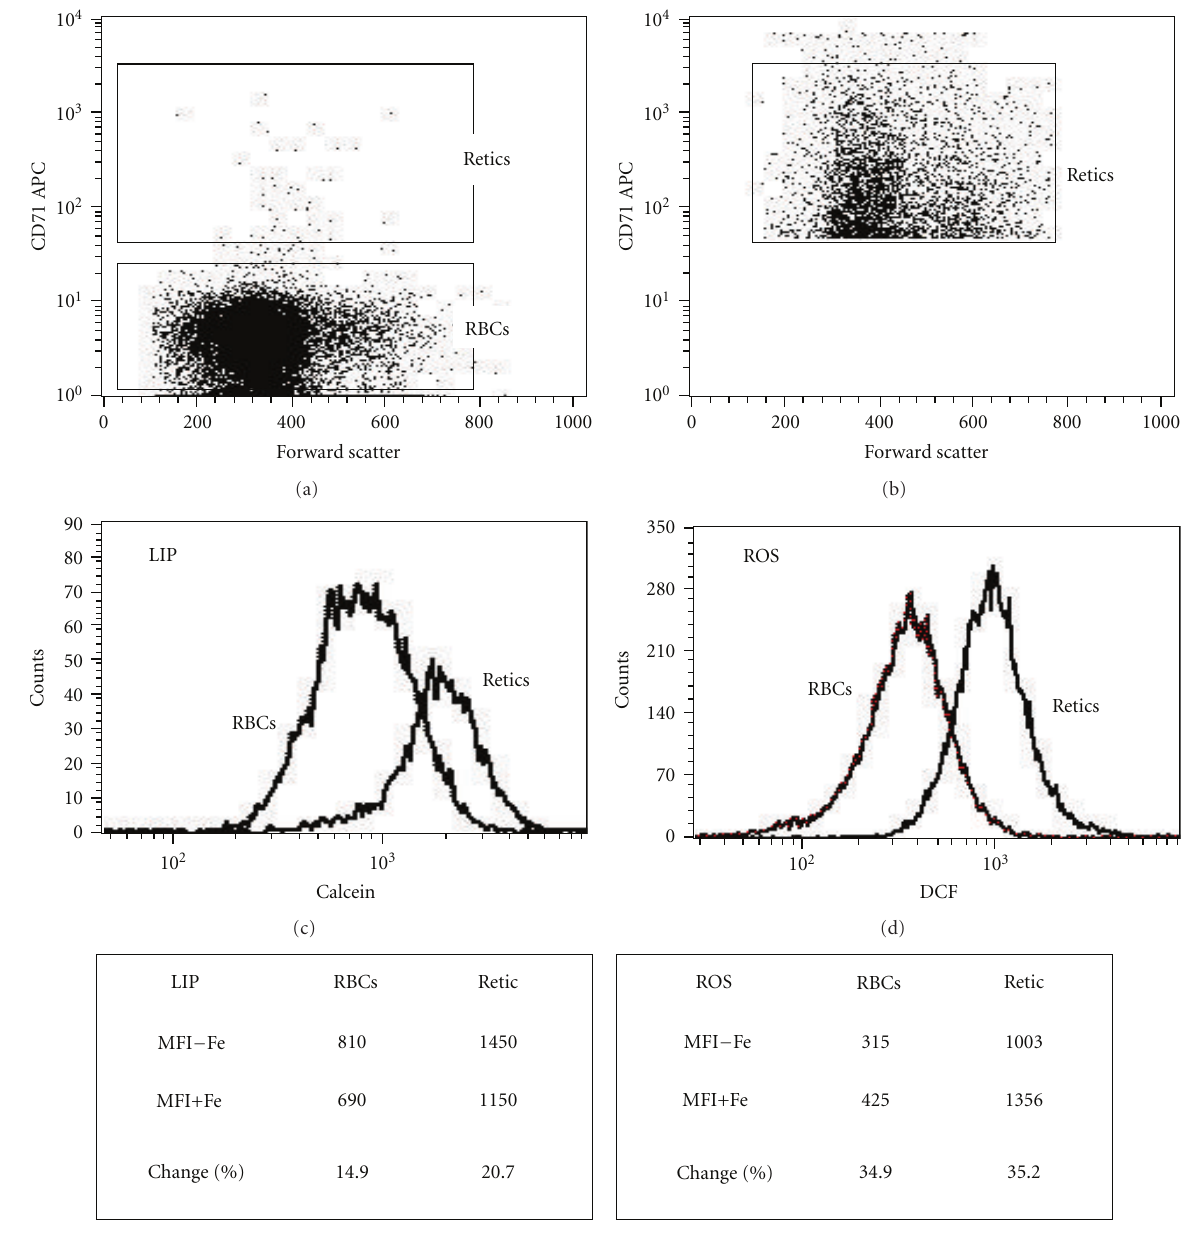
Figure 1: Flow cytometry measurement of iron uptake and reactive oxygen species (ROS) generation in RBCs and reticulocytes. Normal peripheral blood cells were diluted (5 × 10 6 /ml) in PBS, stained with CA-AM or DCF and an APC-conjugated anti-CD71 antibody. Following washing with PBS, they were resuspended in their autologous plasma and then incubated with (+Fe) or without ( − Fe) 20 μ M FeSO 4 for 1hr. (a) A FSC × CD71 dot-plot, showing the gates for RBCs (CD71 − ) and reticulocytes (retics) (CD71 + ). (b) A FSC × CD71 dot-plot of events acquired in the retic gate. (c, d) Histogram distributions of both populations with respect to CA- and DCF-fluorescence, respectively. (e, f) Summaries of the results obtained in each population following incubation with and without Fe. The MFIs and the percent change in the MFIs of each population incubated with and without Fe, calculated per the basal fluorescence (MFI − Fe) are indicated.